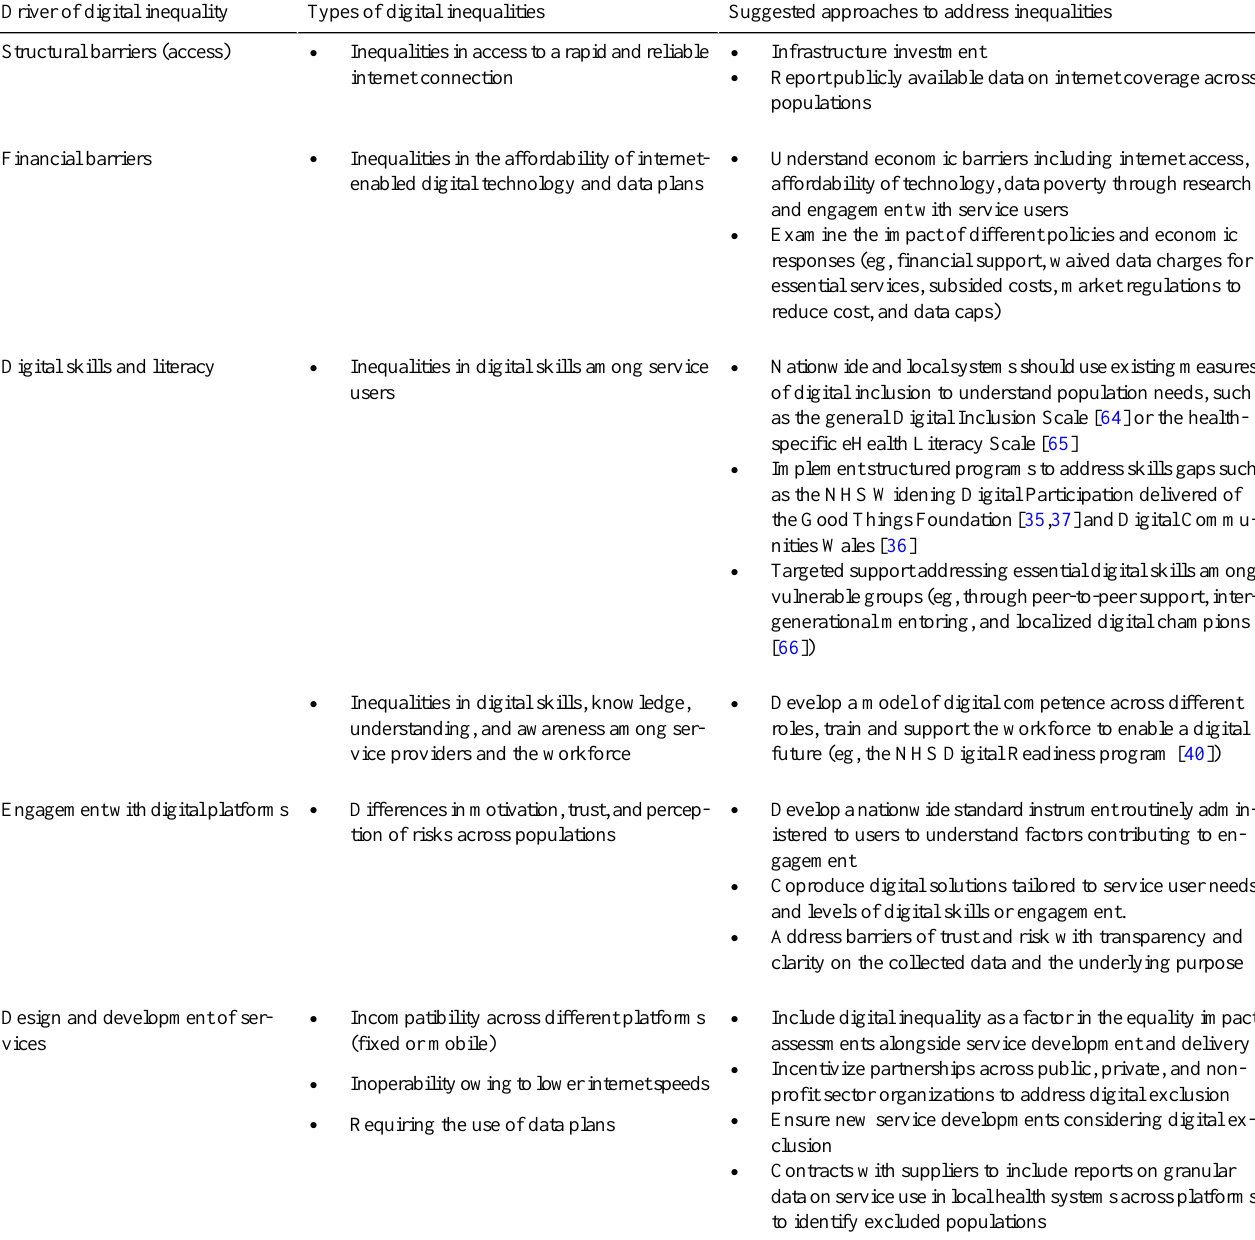
Suggested approaches to address inequalitiesTypes of digital inequalitiesDriver of digital inequality